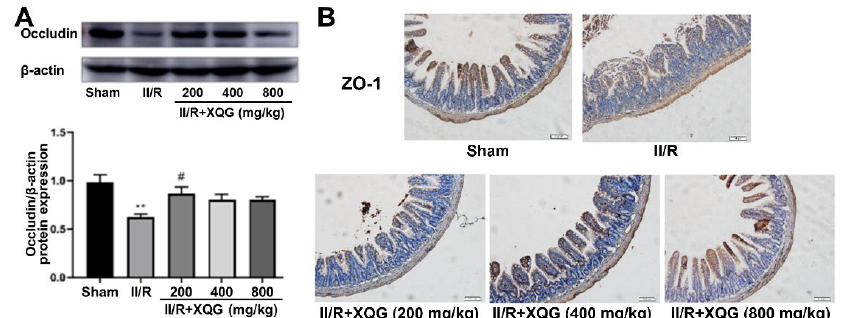
Figure 3. XQG alleviated II/R-induced intestinal barrier injury. ( A ) The expression level of Occludin in intestinal tissue; ( B ) Immunohistochemical expression of ZO-1 in intestinal tissue (scale = 100 μm). All values were expressed as mean ± SEM ( n ≥ 3). ** p < 0.01 vs. sham group while # p < 0.05 vs. II/R group.